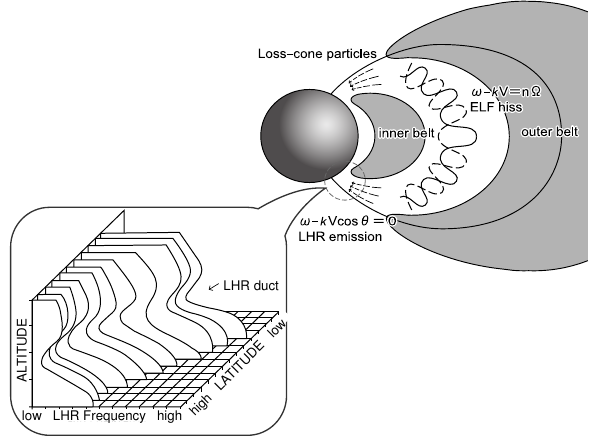
Fig. 10. Schematic illustration of the hypothesis responsible for LHR band emission